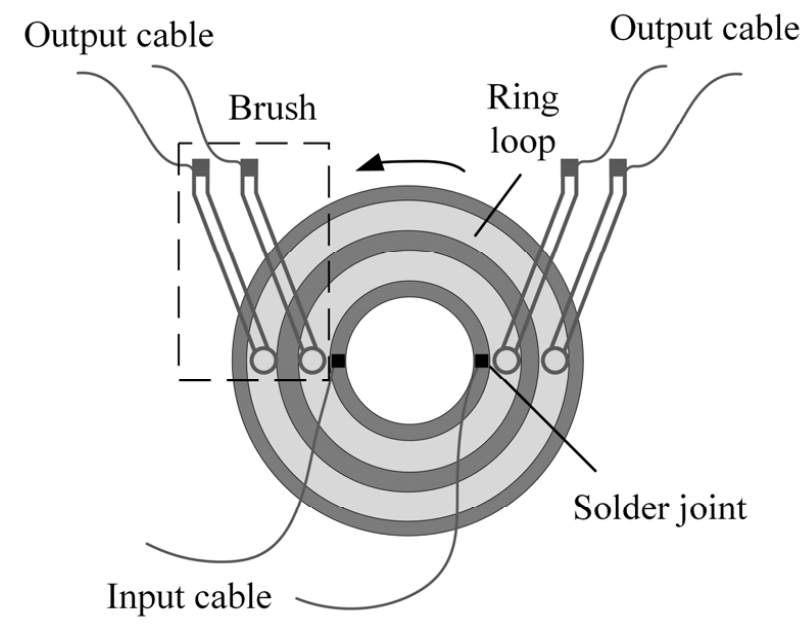
Figure 9. Disc slip ring structure diagram [15].